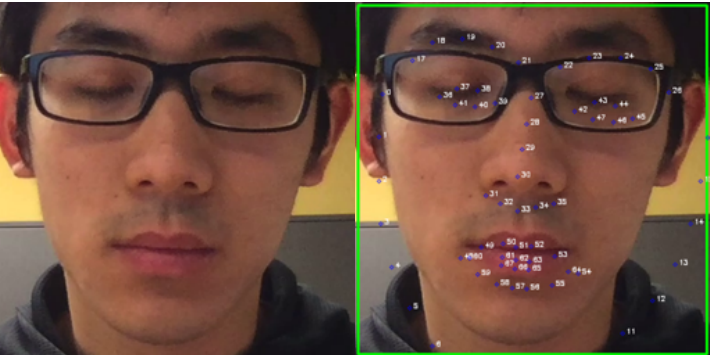
Figure 14. ( left ) Frame of subject 60’s drowsy video. ( right ) Landmark detection of the